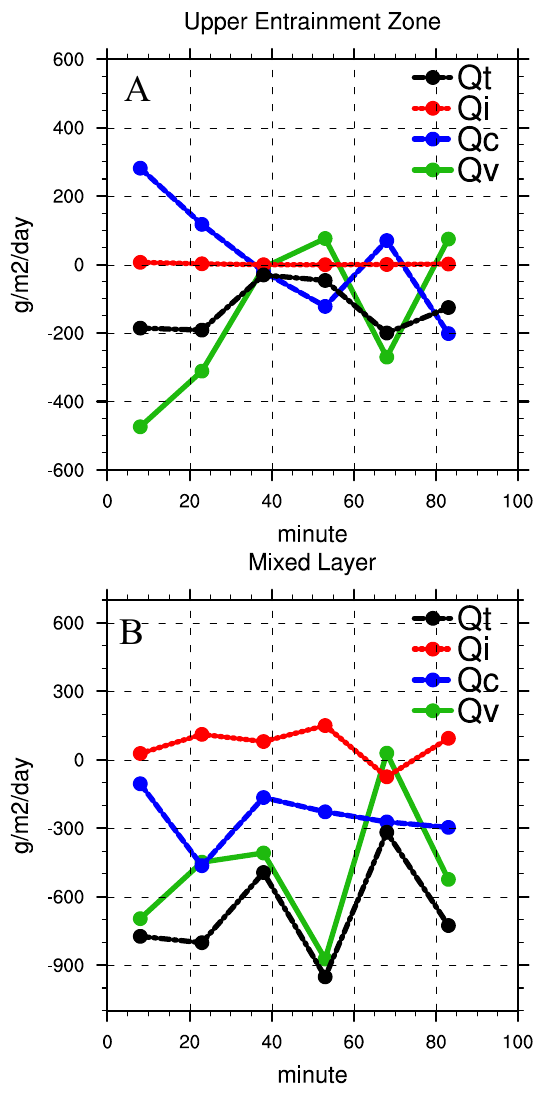
Fig. 12. Time series of 15-min averaged water content tendencies from 20:00Z–21:29Z in upper entrainment zone (A) and mixed layer (B) , in units of gm − 2 day − 1 .